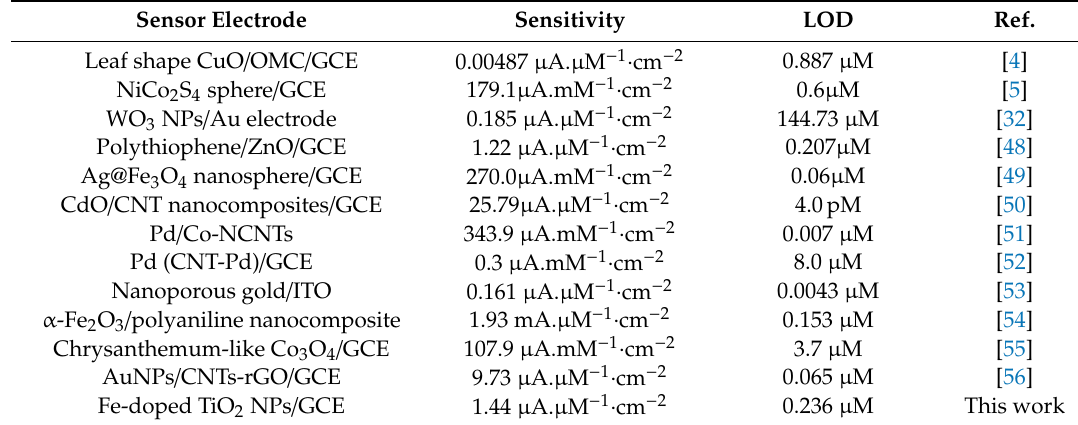
Table 1. Comparison of the sensor parameters of the Fe-doped TiO 2 coated GCE sensor with some recently reported hydrazine electrochemical sensor